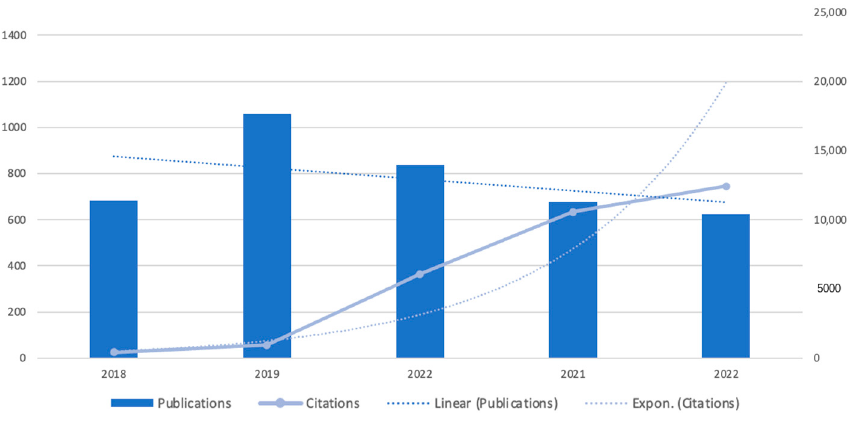
Figure 3. Publications and citations. Table 2. Top 10 most active regions, research areas, and organizations of